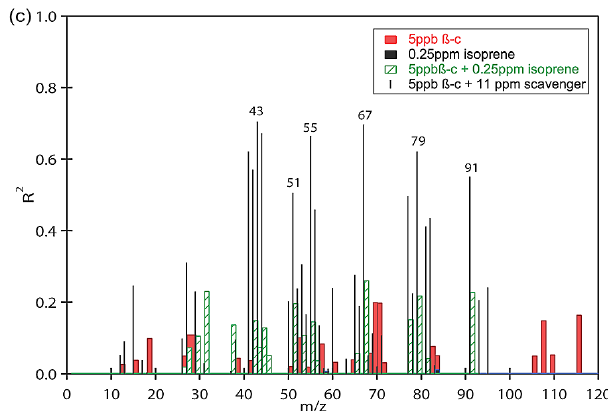
Fig. 4c. Linear regression correlations (represented by R 2 ) between κ and the abundant mass-to-charge ratios ( m/z) of O 3 -initiated